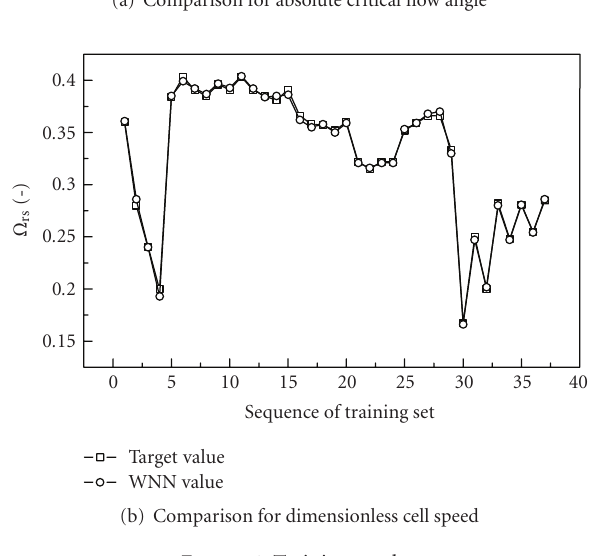
Figure 4: Training